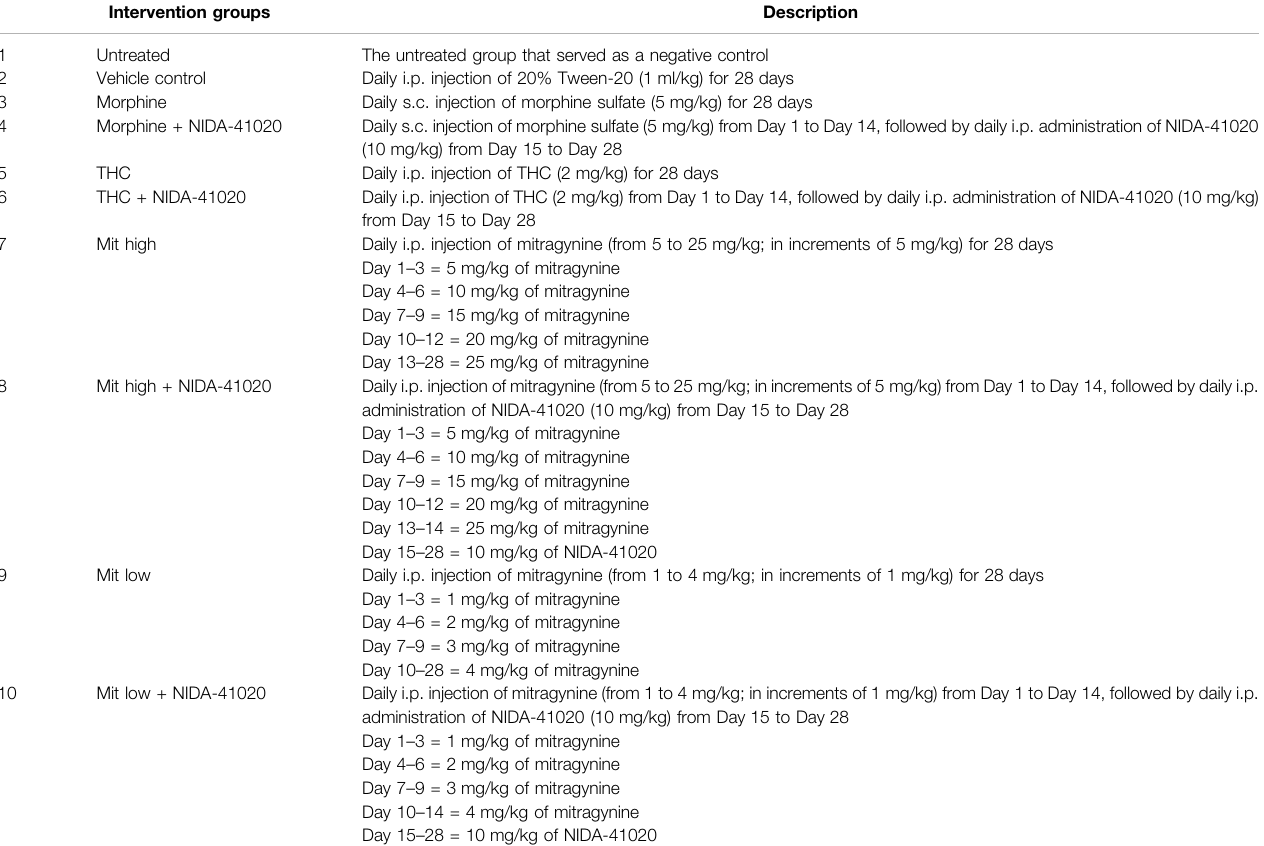
TABLE 1 | Description of experimental groups and drug